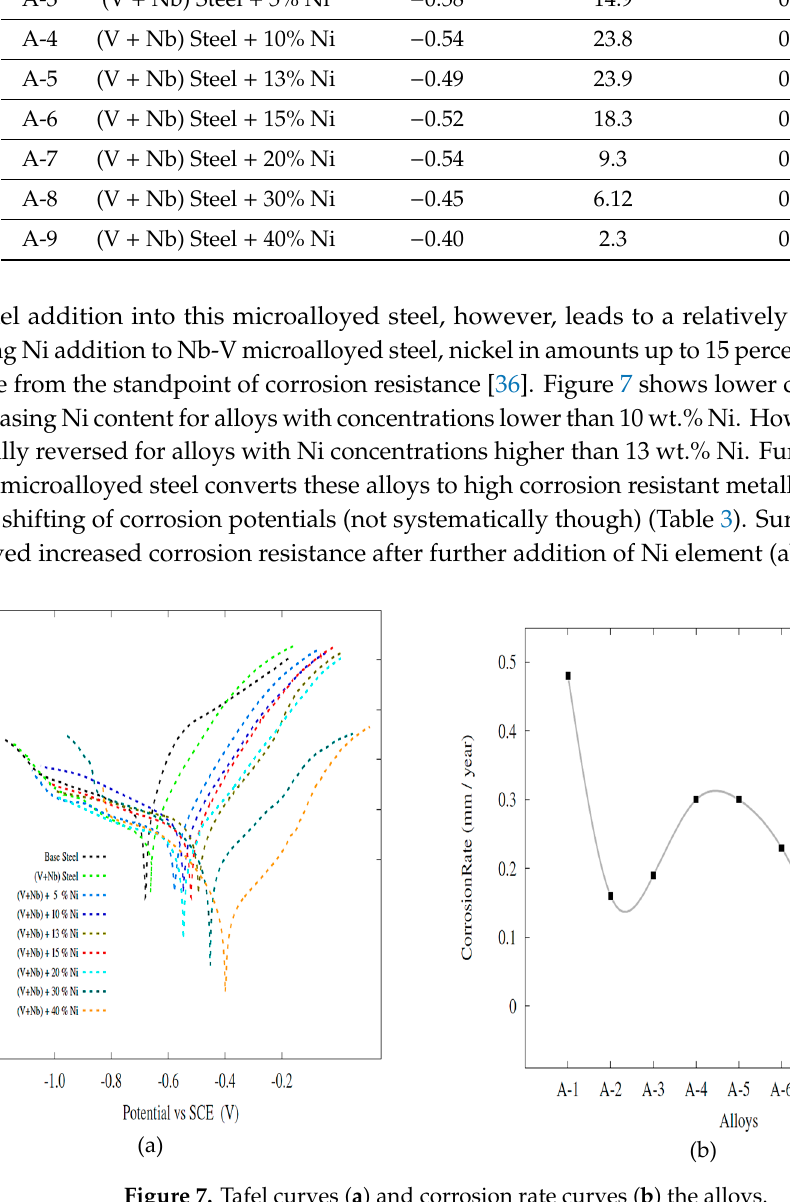
Figure 7. Tafel curves ( a ) and corrosion rate curves ( b ) the alloys.